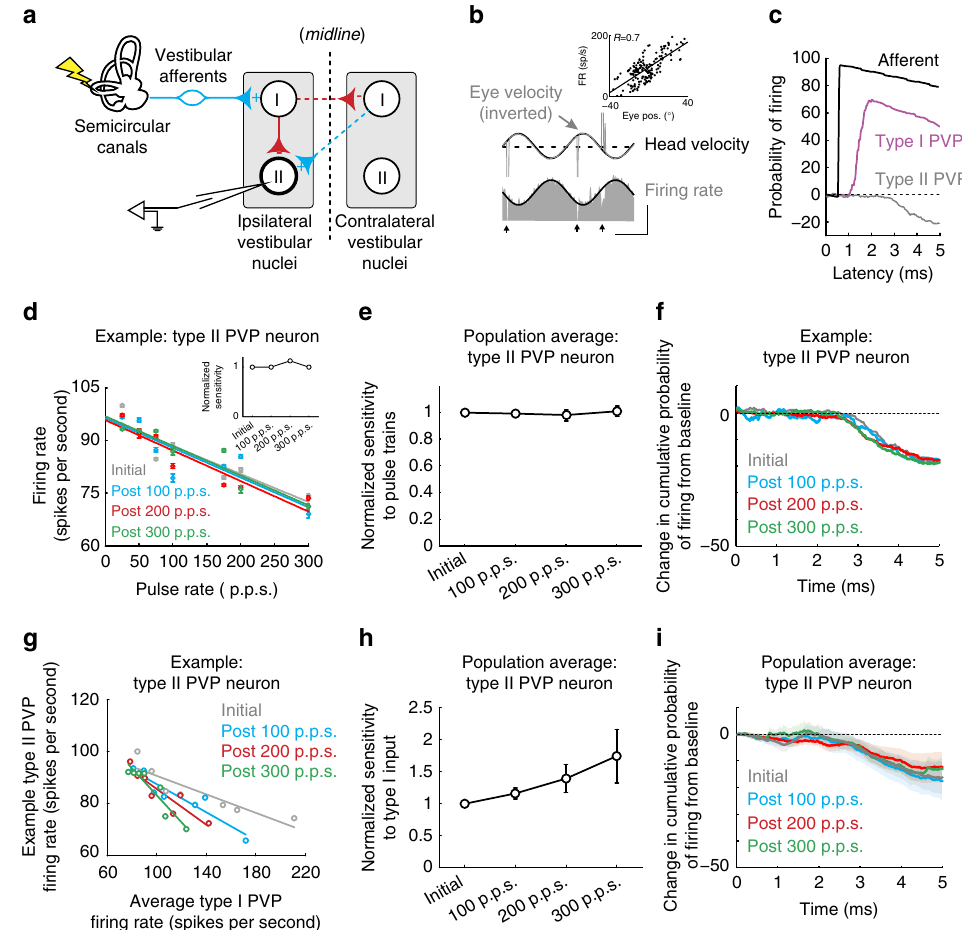
Figure 5 | Rapid complementary changes in indirect inhibitory brainstem pathways. ( a ) Diagram of local inhibitory pathway within the vestibular nuclei. ( b ) Firing rate of example type II PVP neuron during VOR. Arrows highlight when saccades occurred. Inset shows example neuron’s eye position sensitivity. Calibrations bars, 100 (cid:2) per s, 100 spikes per s, 1s. ( c ) Probability of firing as a function of latency from onset of individual pulses for vestibular afferent, as well as for type I and II PVP neurons. ( d ) Plot of firing rate as a function of pulse rate for example neuron before and after activation of the vestibular nerve. Inset shows normalized sensitivity (slope of firing rate versus pulse rate) for example type II PVP neuron. ( e ) Population average of normalized sensitivity for type II PVP neurons ( n ¼ 10). ( f ) Probability of firing as a function of latency following individual pulses for example neuron before and after activation of vestibular nerve. ( g ) Input–output relationship between type I and type II PVP neurons (that is, type II PVP example neuron firing rate as a function of average type I PVP neuron firing rate) before and after activation of the vestibular nerve. ( h ) Population average of normalized sensitivity to type I input for type II PVP neurons ( n ¼ 10). ( i ) Population averaged probability of firing as a function of latency following individual pulses before and after activation of vestibular nerve. Error bars and shaded area represent ± s.e.m. NATURE COMMUNICATIONS|7:11238|DOI: